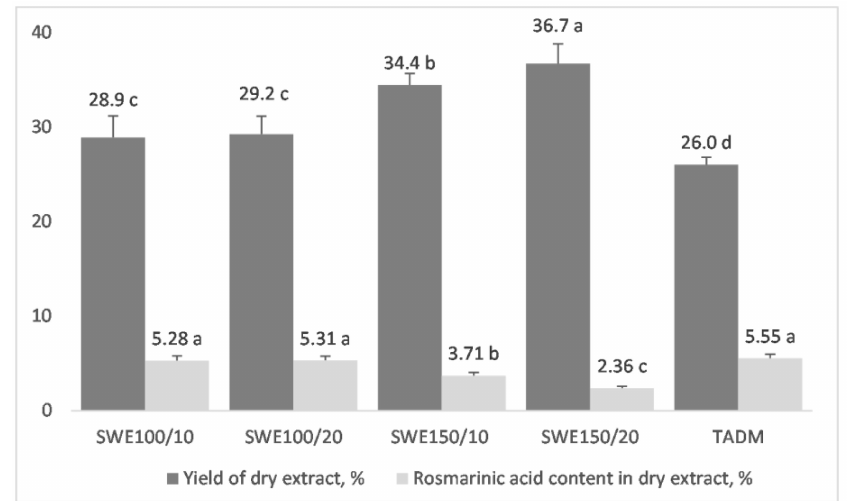
Figure 2. Yield of extract and rosmarinic acid content of dry extracts, obtained by different extraction methods. Results are presented as mean values ± SD. There are no significant differences among values marked with the same letters (a, b, c, d) within individual